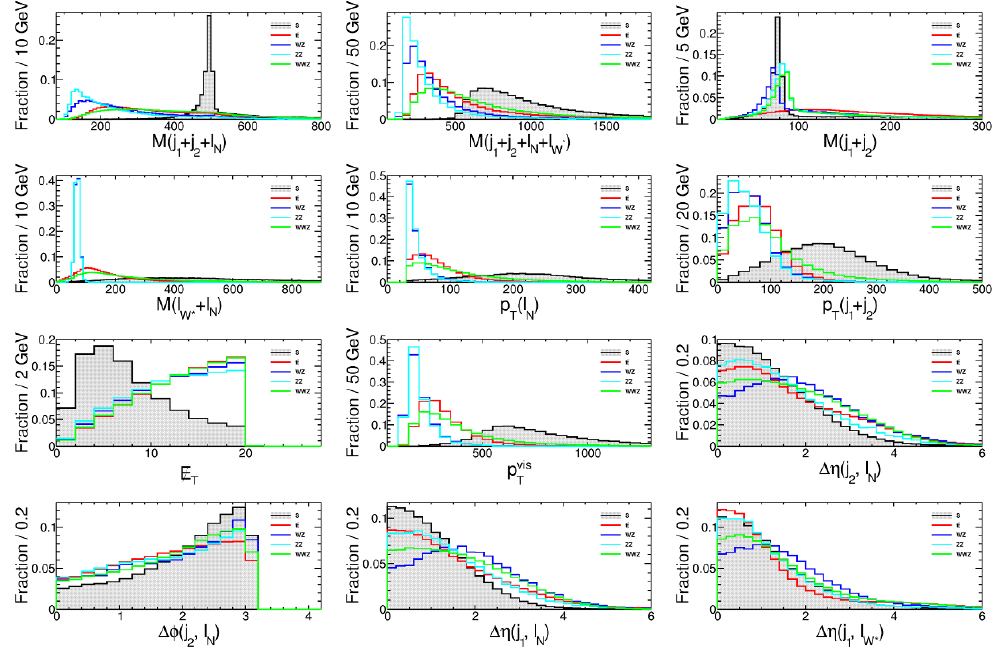
Figure 9 . Kinematic distributions of some selected observables for the signal with M N = 500 GeV (S, black with (cid:12)lled area), and for SM background processes of t (cid:22) t (red), WZ (blue), ZZ (cyan), and WWZ (green) after applying the pre-selection cuts at the FCC-hh. { 18